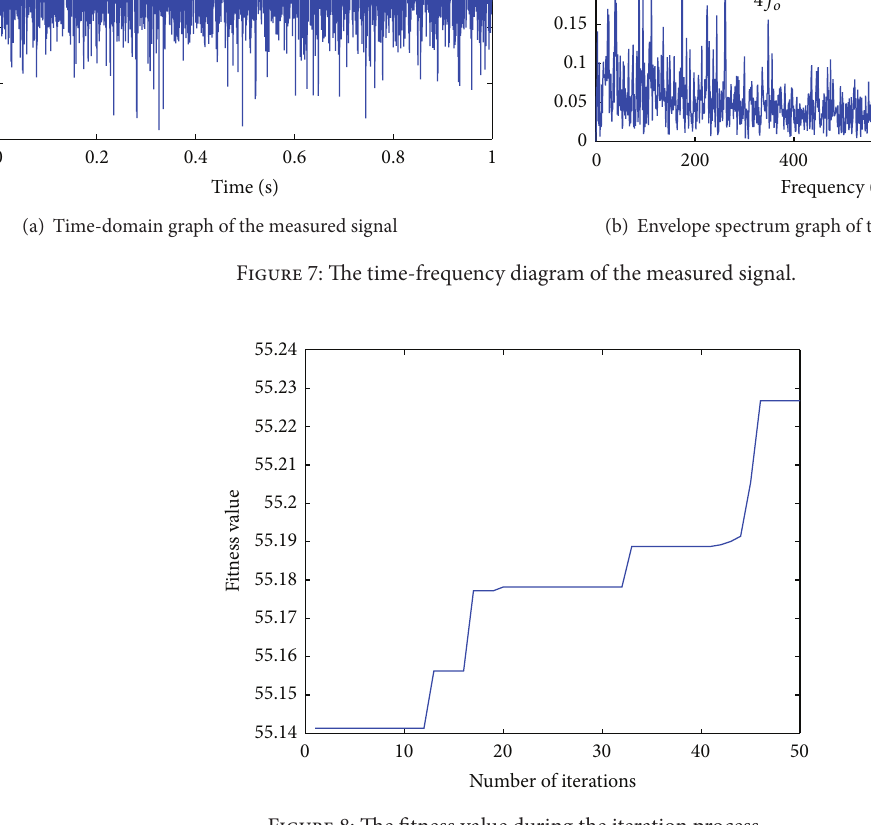
Figure 8: The fitness value during the iteration process.